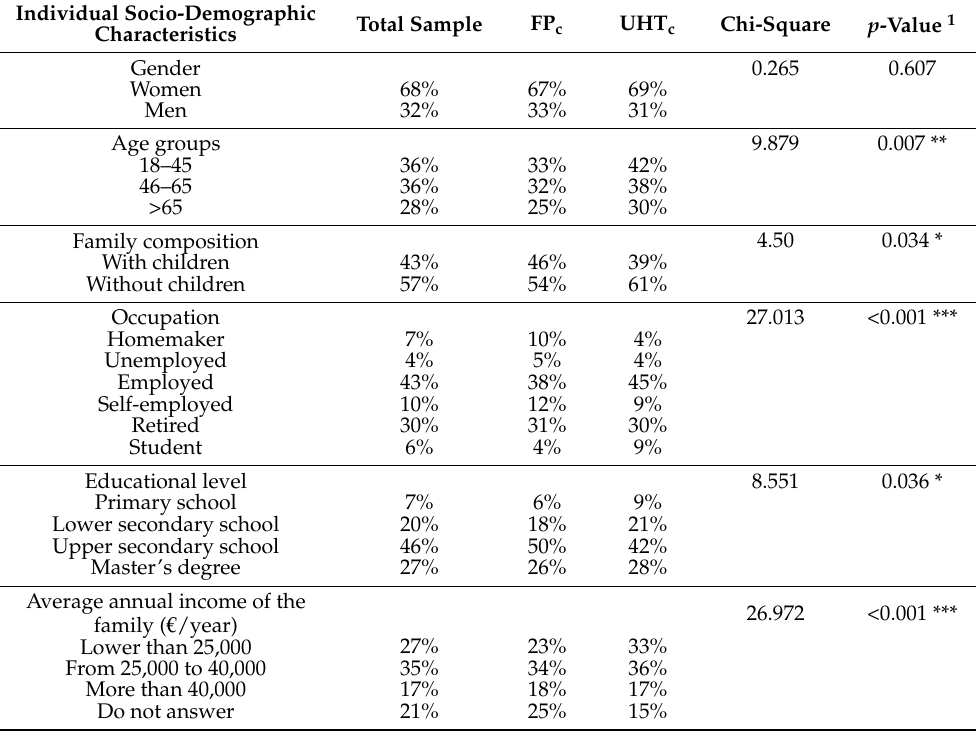
Table 2. Socio-demographic profiles of FP ( n = 677) and UHT ( n = 430) milk consumers ( n = 1107). Individual Socio-Demographic